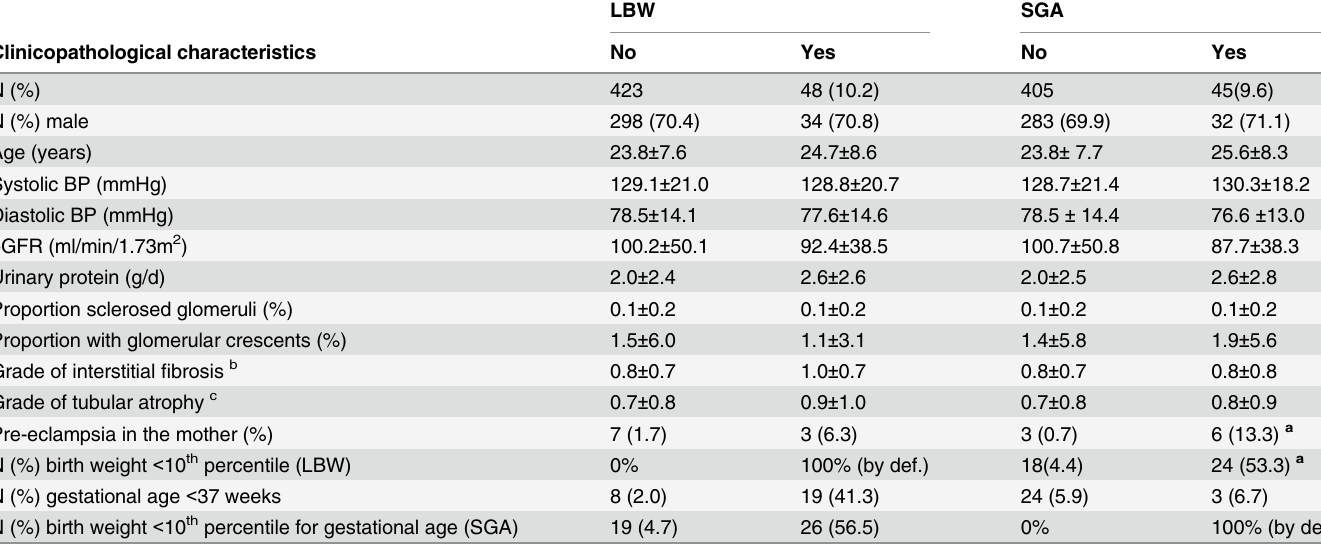
Table 1. Cohort characteristics at the time of IgAN diagnosis stratified by Low Birth Weight and Small for Gestational Age, Norway 1967 – 2013. LBW